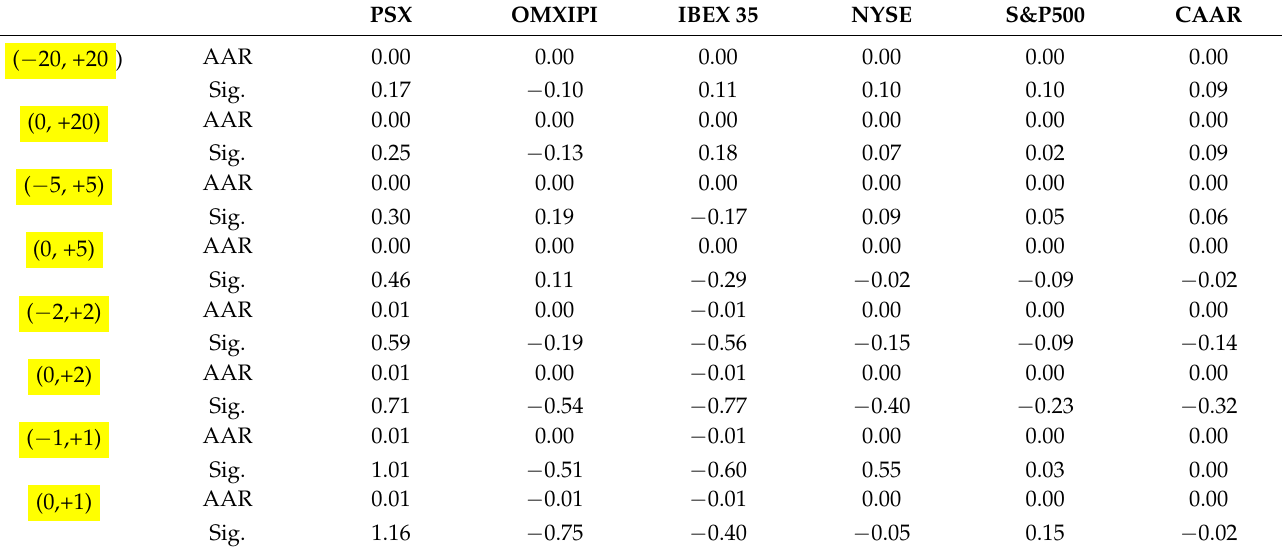
Table A9. Average of abnormal returns and cumulative average abnormal returns (News of Panama